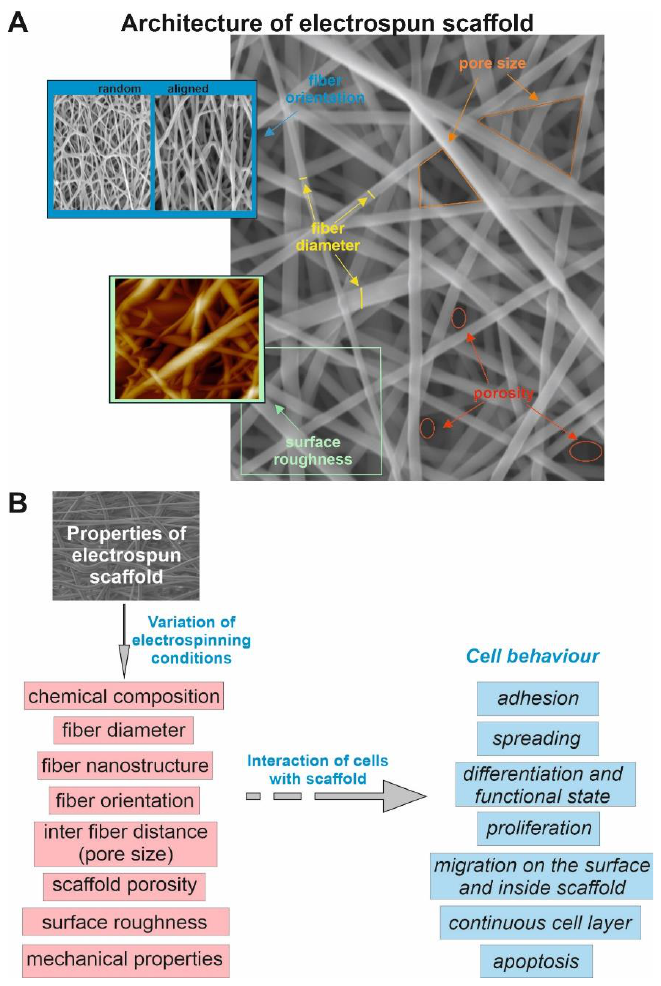
Figure 2. Structural parameters of electrospun scaffold ( A ). Scaffold properties affecting the behavior of cells ( B